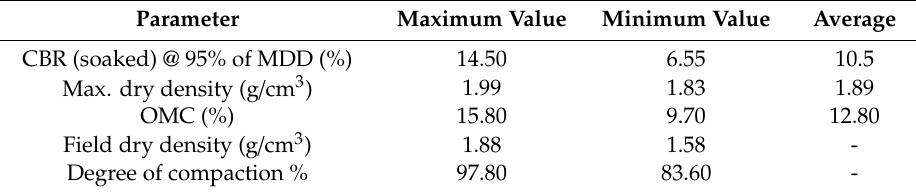
Table 1. Compaction and California Bearing Ratio (CBR) characteristics of sabkha deposits.